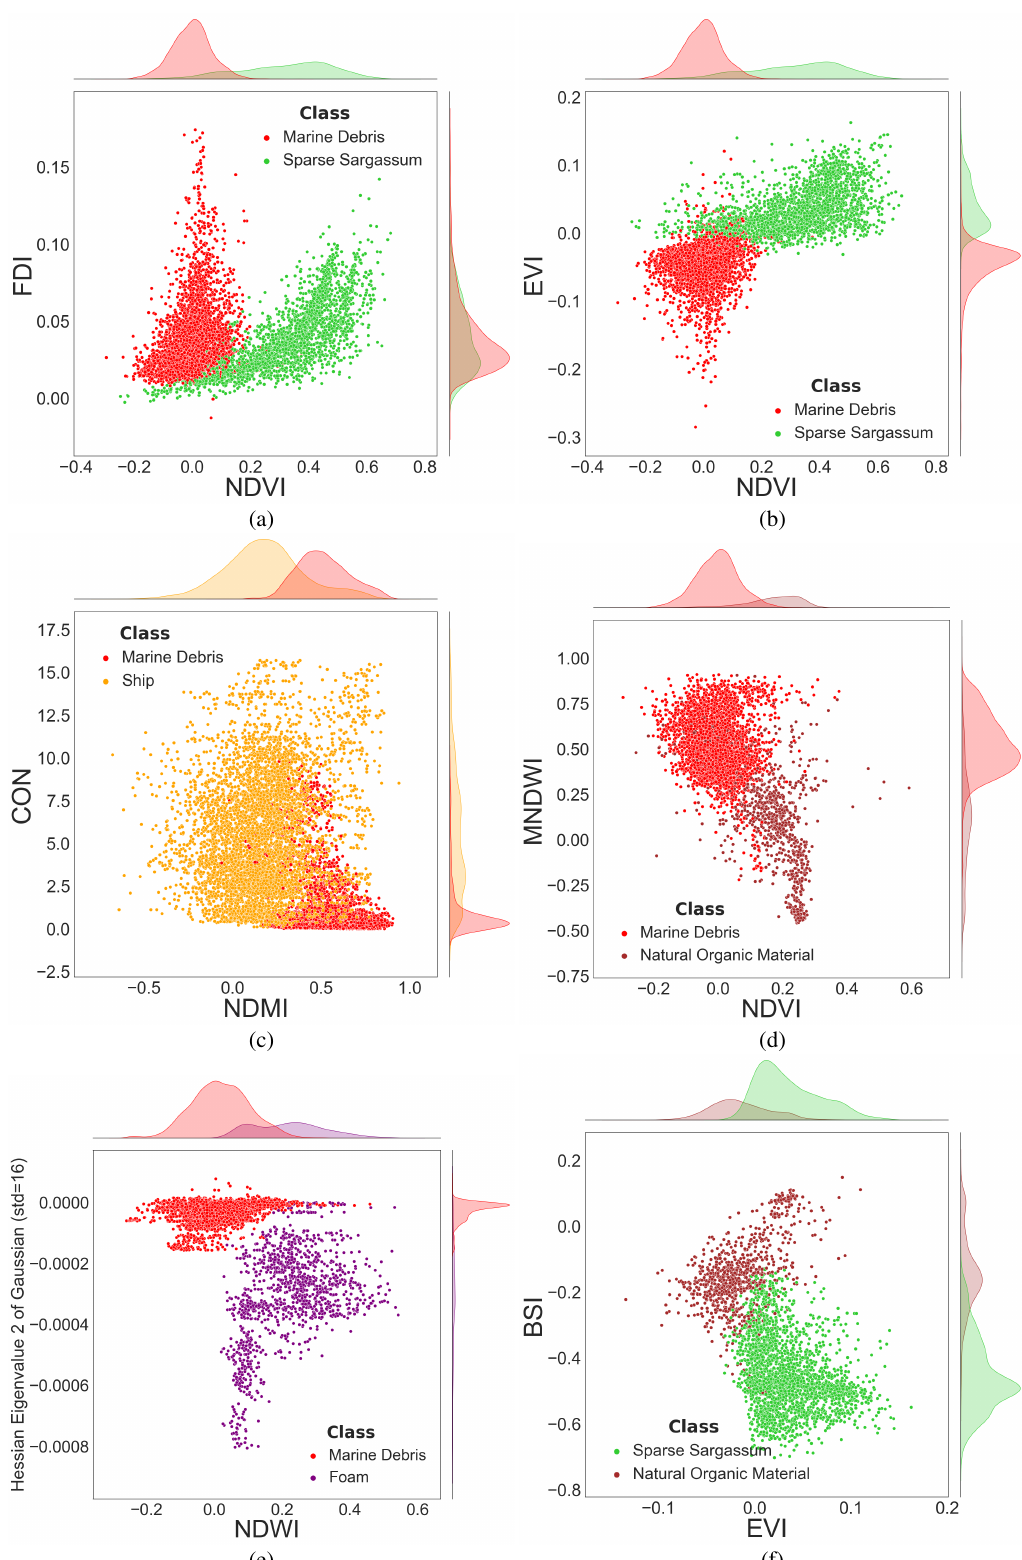
Figure 4. Scattergrams for the qualitative evaluation of challenging cases: (a) NDVI and FDI for Marine Debris and Sparse Sargassum , (b) NDVI and EVI for Marine Debris and Sparse Sargassum , (c) NDMI and CON for Marine Debris and Ship, (d) NDVI and MNDWI for Marine Debris and Natural Organic Material , (e) NDWI and Hessian Eigenvalue 2 of Gaussian of σ = 16 for Marine Debris and Foam (f) EVI and BSI for Natural Organic Material and Sparse Sargassum